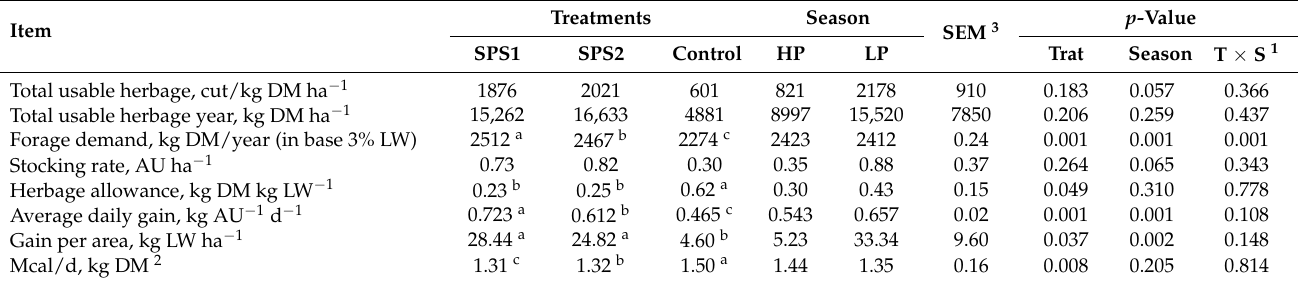
Figure 4. Total usable herbage of guinea grass Panicum maximum under silvopastoral systems evaluated according to the season at the year p = 0.05. HP ( A ); LP ( B ). Table 3. Least square mean of guinea grass Panicum maximum evaluated in different silvopastoral